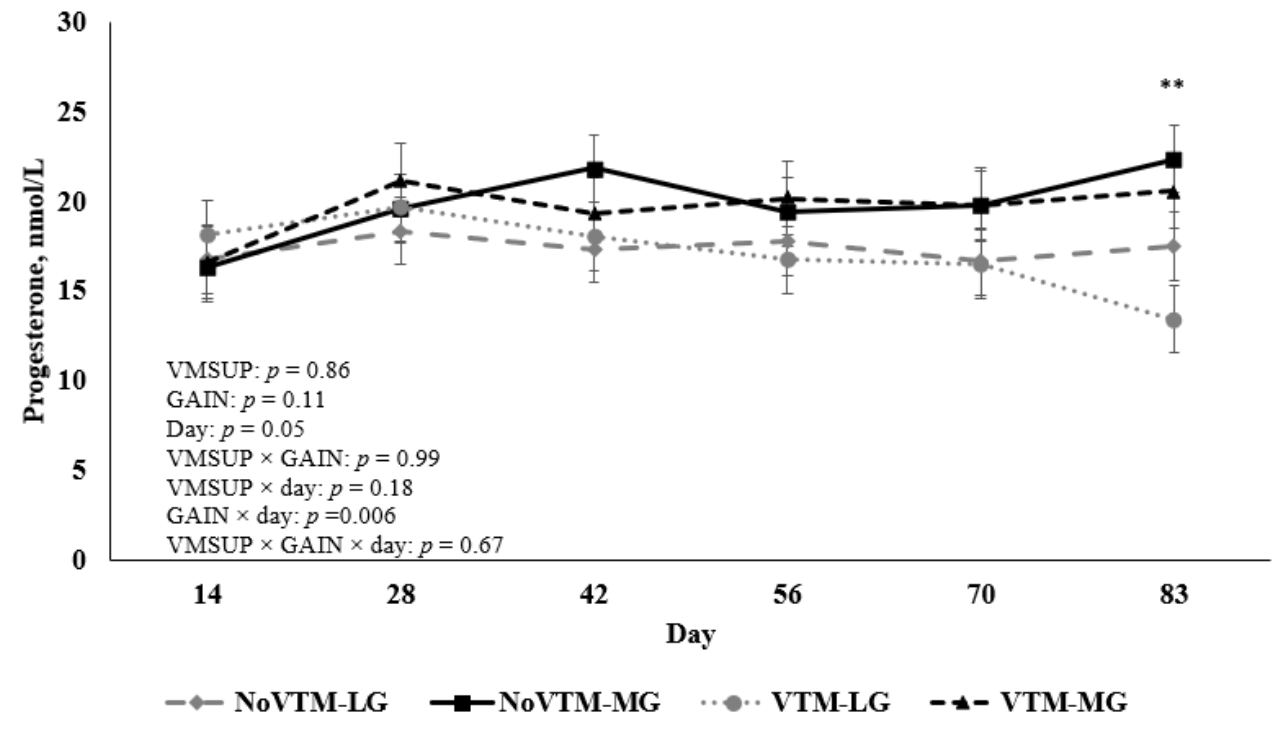
Figure 4. Effect of vitamin and mineral supplementation [VMSUP; supplemented (VTM) vs. unsupplemented (NoVTM); from pre-breeding to d 83 of gestation] and two different rates of gain [GAIN; low gain (LG), 0.28 kg/d, vs. moderate gain (MG), 0.79 kg/d; from breeding to d 83 of gestation] on progesterone (P4) concentrations. NoVTM-LG ( n = 9): No vitamin and mineral supplement, low gain; NoVTM-MG ( n = 9): No vitamin and mineral supplement, moderate gain; VTM-LG ( n = 9): Vitamin and mineral supplement, low gain; VTM-MG ( n = 8): Vitamin and mineral supplement, moderate gain. A rate of gain × Day interaction ( p = 0.006) was observed for P4 concentrations, which were similar between LG (low gain, 0.28 kg/d) and MG (moderate gain, 0.79 kg/d) on d 14 to 70; and were greater ( p = 0.05) for MG compared with LG on d 83, as indicated by **. Values are least squares means, with error bars depicting standard error.